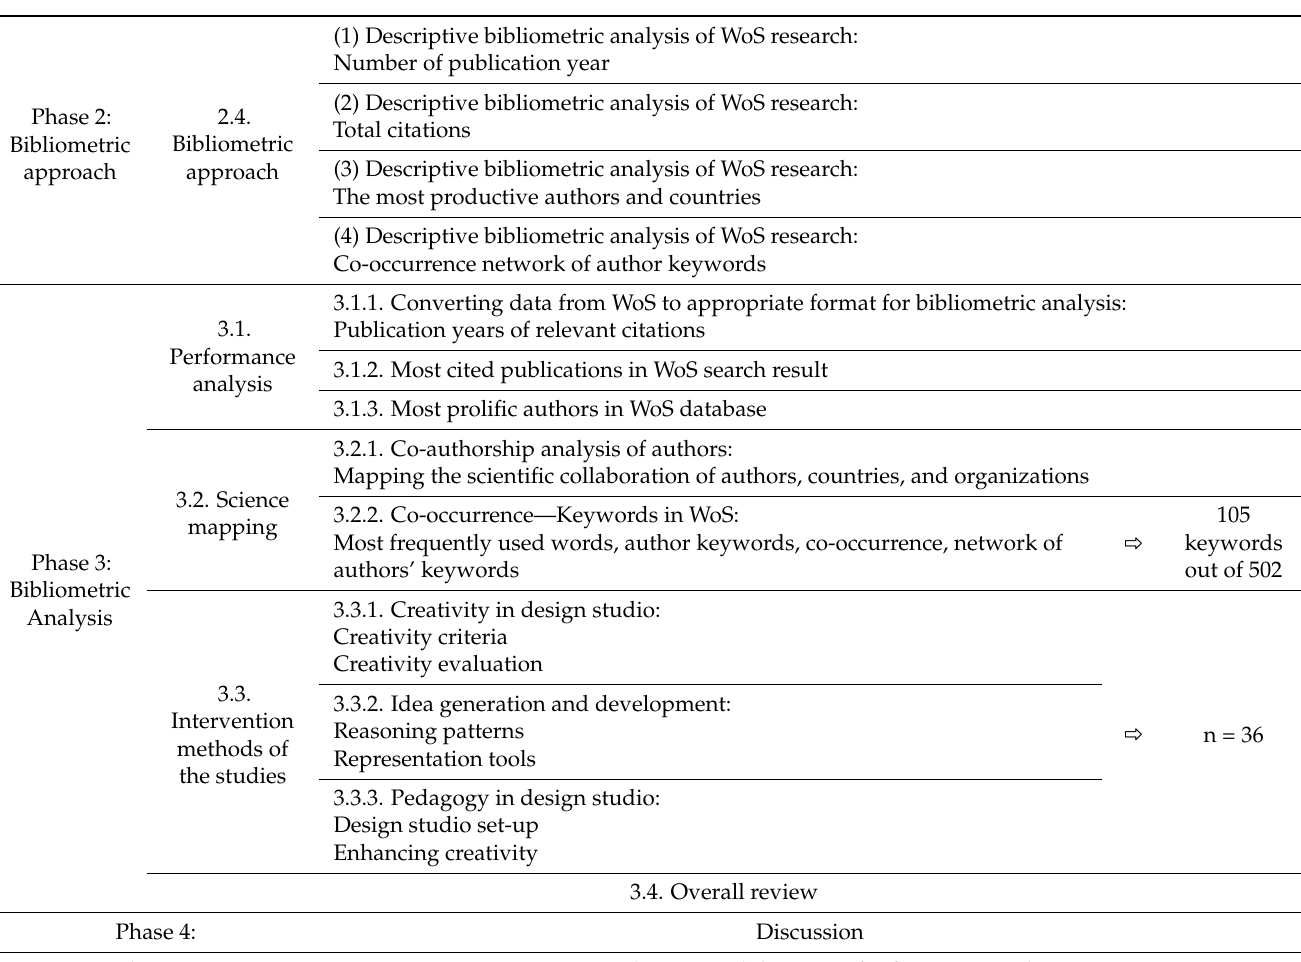
Figure 1. The process of the bibliometric analysis using the VOSviewer.